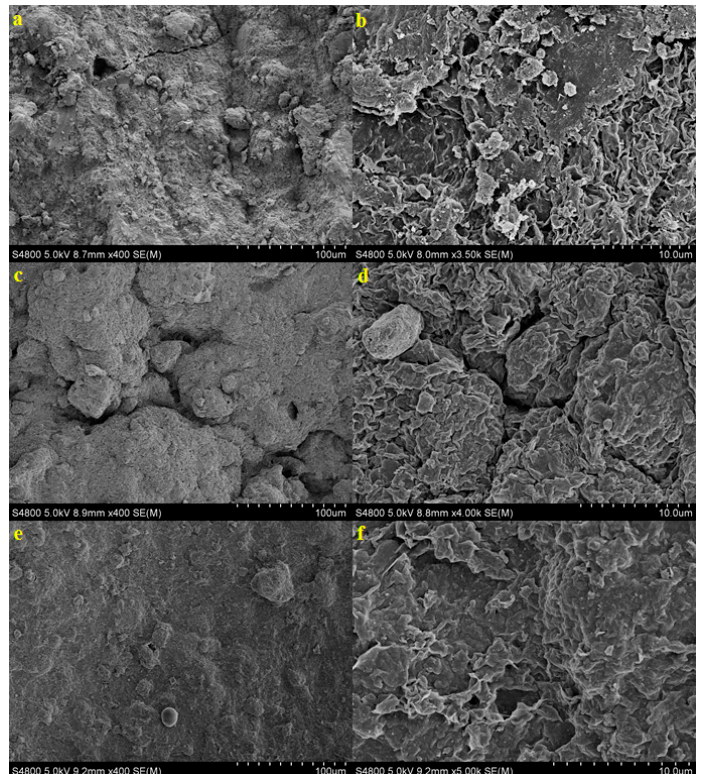
Figure 12. SEM photos of filter cakes formed by different test fluids. ( a ) 4% bentonite suspension (400-fold magnification); ( b ) 4% bentonite suspension (3500-fold magnification); ( c ) 4% bentonite suspension with 0.3% PHPA (400-fold magnification); ( d ) 4% bentonite suspension with 0.3% PHPA (4000-fold magnification); ( e ) 4% bentonite suspension with 0.3% SDCap (400-fold magnification); ( f ) 4% bentonite suspension with 0.3% SDCap (5000-fold magnification).